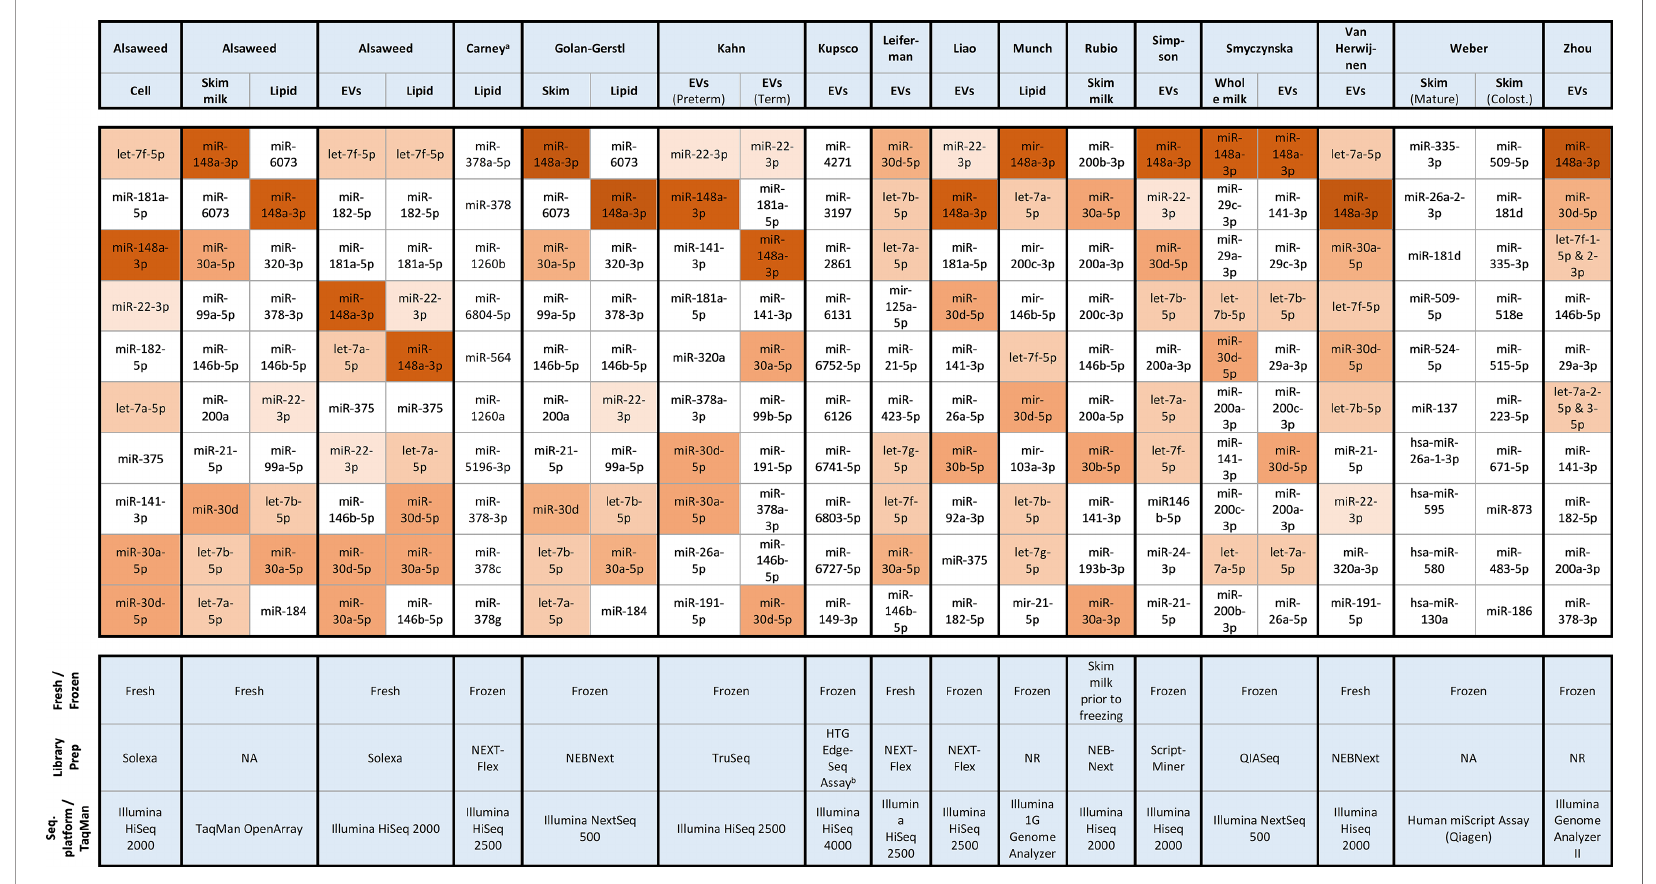
FIGURE 2 | Top 10 mature miRNA from RNA-seq and TaqMan OpenArray studies. Colost., Colostrum; EV, Wxtracellular vesicles; NA, not applicable; a Carney et al. (37) assessed lipid and skim fraction, however the top 10 miRNA could only be deduced for the lipid fraction in the Supplementary Table on differential expression between term and preterm milk which reports total reads per miRNA, b Kupsco et al. (56) employed HTG EdgeSeq miRNA Whole Transcriptome Assay, a novel sequencing platform with probe-based library preparation. Bozack et al. (36) and Wu et al. (51) also used array-based technologies, however these articles do not supply information regarding the top 10